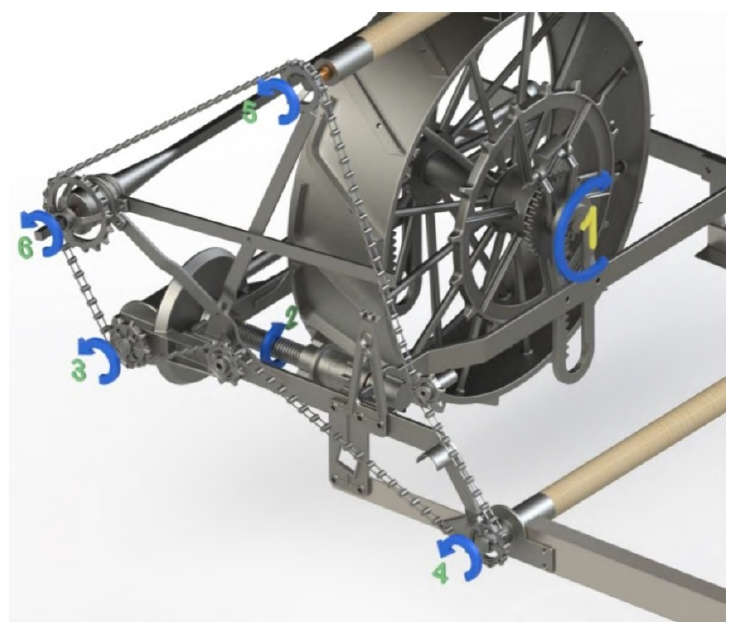
Figure 26. Description of the first set of elements of the transmission system.